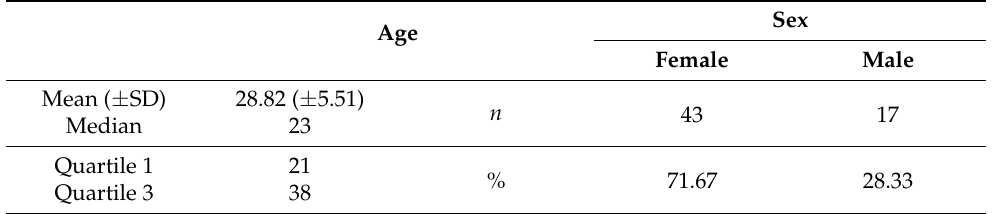
Table 1. Characteristics of the study patients.